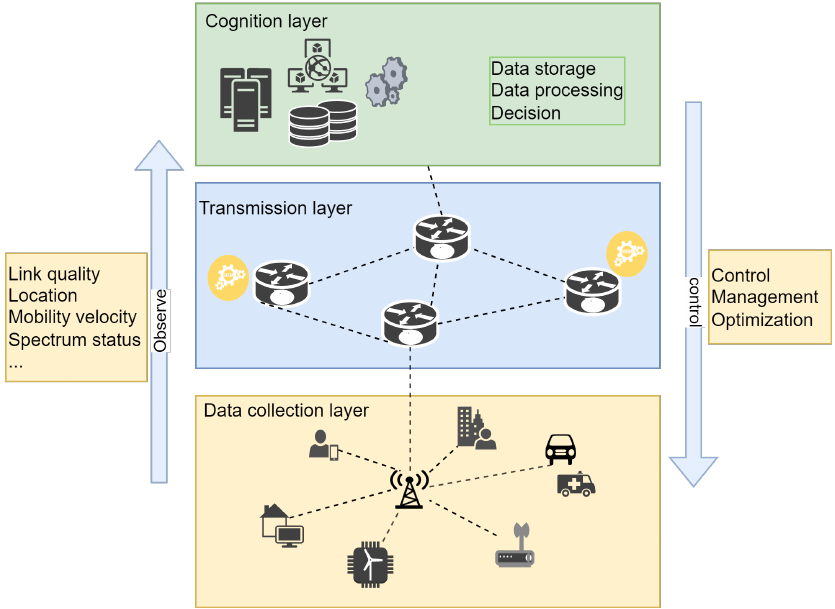
Figure 2. Integration of ML into wireless network